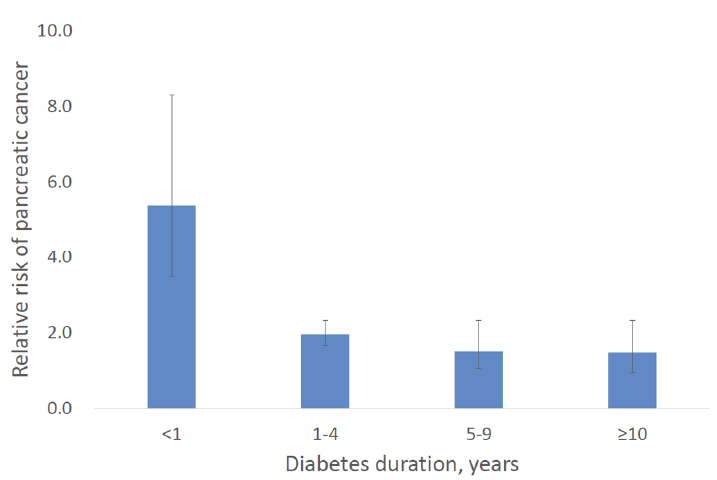
Figure 2. Relative risks of pancreatic cancer in patients with diabetes mellitus according to diabetes duration. The data are quoted from Ben Q et al. [9]. Bars indicate 95% confidence intervals.